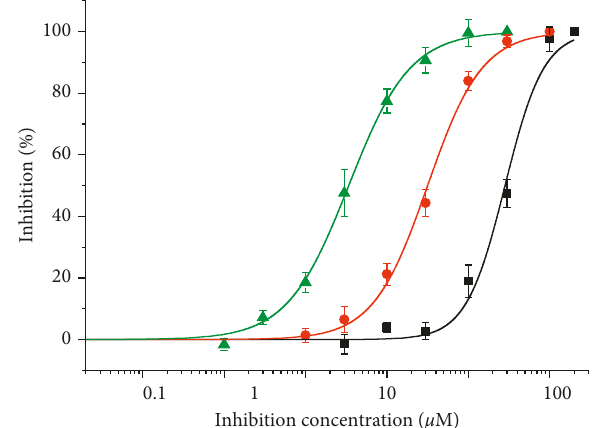
Figure 3: The mean MIC in µ g against all the test bacteria.